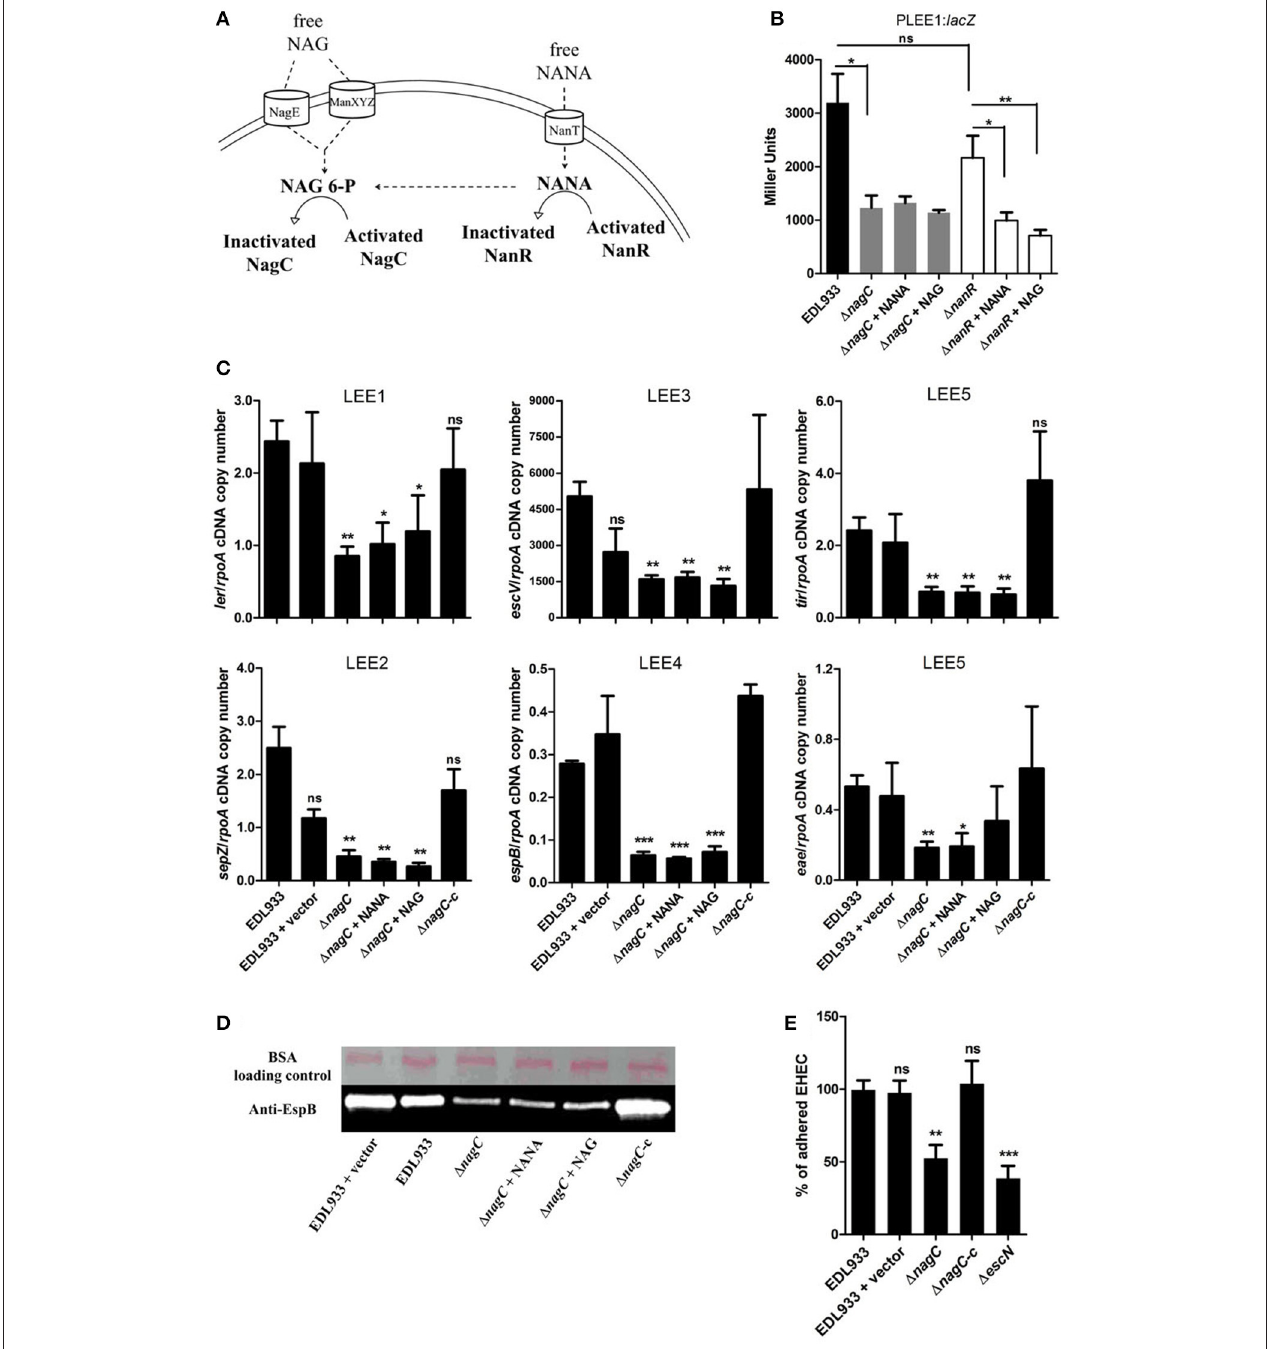
FIGURE 2 | NagC is a transcriptional activator of the LEE genes. (A) Schematic representation of the influence of NANA and NAG on the activity of the transcriptional regulators NagC and NanR. (B) β -galactosidase assays using the P LEE1 : lacZ transcriptional fusion integrated into EDL933 or the isogenic mutants 1 nagC and 1 nanR . The strains were grown in DMEM with or without NANA or NAG at 1 mM and harvested at OD 600 = 0.6. Results are presented as Miller Units. (C) qRT-PCR measurement of LEE gene expression. EDL933, the isogenic mutant 1 nagC and the complemented strain 1 nagC -c were grown in DMEM with or without NANA or NAG at 1mM. Results are shown as the ratio copy number of the LEE transcripts/copy number of rpoA transcripts. (D) Western blot analysis of the EspB secretion by EDL933, the isogenic mutant 1 nagC and the complement grown in DMEM with or without NANA or NAG at 1mM. BSA was used as a loading control. (E) HeLa cells were co-incubated for 90min with either the wild type EDL933 strain, 1 nagC mutant, the 1 nagC complemented strain or the 1 escN mutant. Adhered bacteria were harvested and counted on agar plates. Results are presented as the percentage of adhered cells compared to the wild type strain EDL933. n ≥ 3, ns for non-significant, * p < 0.05, ** p < 0.01, and *** p < 0.001.